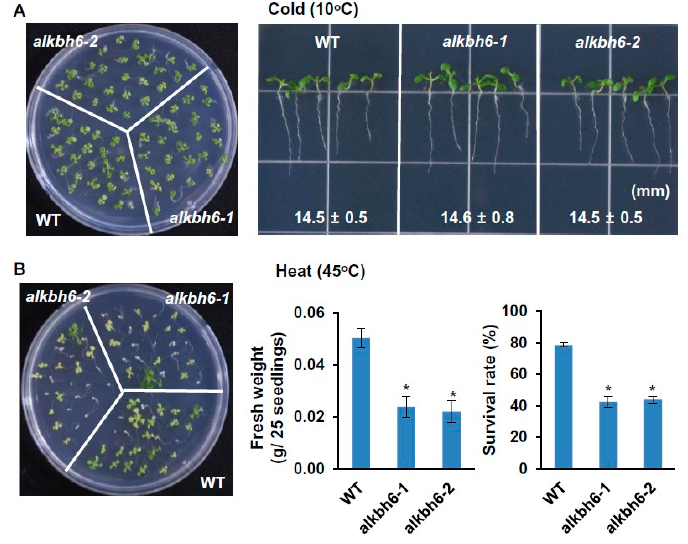
Figure 4. Seedling and root growth of the alkbh6 mutants under cold or heat stress. ( A ) The wild-type (WT) and alkbh6 mutants were grown at 10 °C, and root lengths were measured four weeks after germination. ( B ) Three-day-old seedlings were treated at 37 °C for 1 h and then subjected to heat stress at 45 °C for 4 h. Survival rate and fresh weight of the plants were measured seven days after heat treatment. Values are the mean ± SE obtained from three independent experiments, and the asterisks above columns indicate significant differences (* p ≤ 0.05).